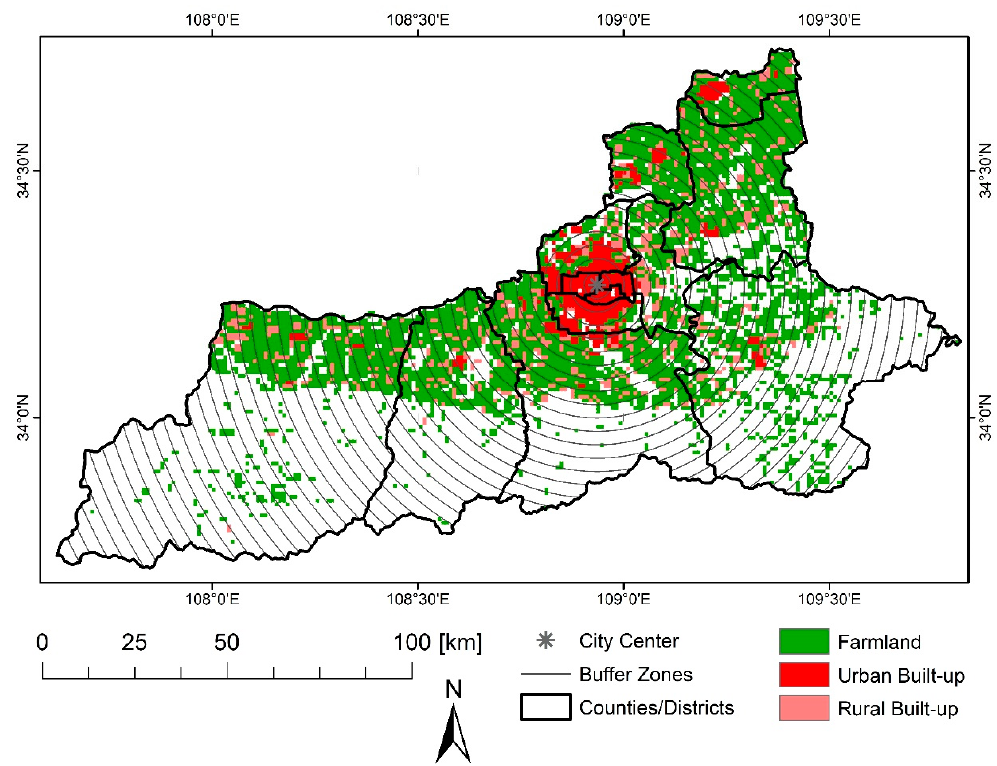
Figure 2. County/district boundaries and buffer zones around the city center in 3 km intervals, and land use for the year 2015. We used the buffer zones and county/district boundaries to define the spatial units for the calculation of the land use intensity index (LUII) along the urban–rural gradient.